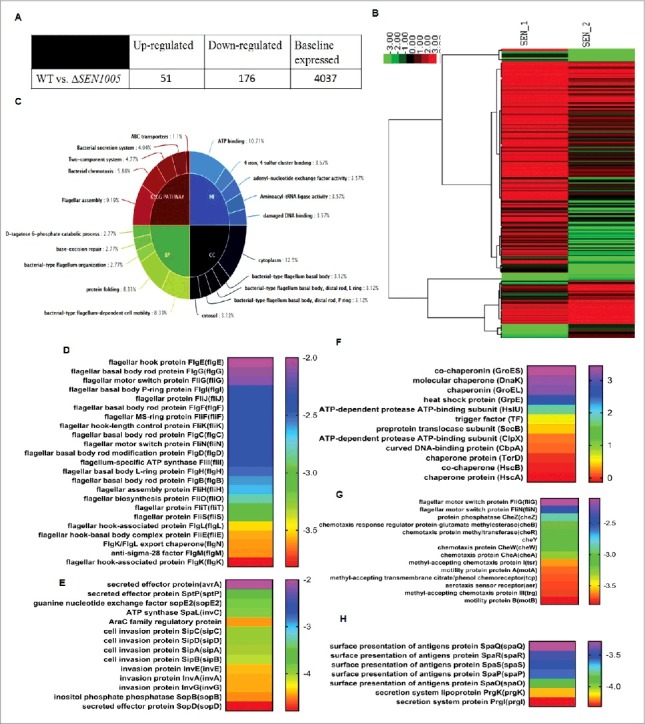
Global variations in gene expressions of WT vs ΔSEN1005. (A) Tabular representation of the number of genes either up-regulated or down-regulated in ΔSEN1005 as compared to WT. (B) Hierarchical clustering of differentially expressed transcripts, SEN_1, WT; SEN_2, ΔSEN1005. (C) Top 5 GO and KEGG Pathway summary to illustrate various functional clusters that are differentially expressed in the two bacterial samples. (D-H) Heat maps showing differentially regulated genes in ΔSEN1005 as compared to WT grouped according to their functions using David 6.7: (D) Flagellar assembly. (E) Epithelial cell invasion. (F) Protein folding. (G) Bacterial chemotaxis. (H) Bacterial secretion system. All the data sets were analyzed and differentially expressed transcripts were selected on the basis of RPKM >1 in either of the pair of samples with Log 2 fold change > = 2 with a t-test P Value <0.05.